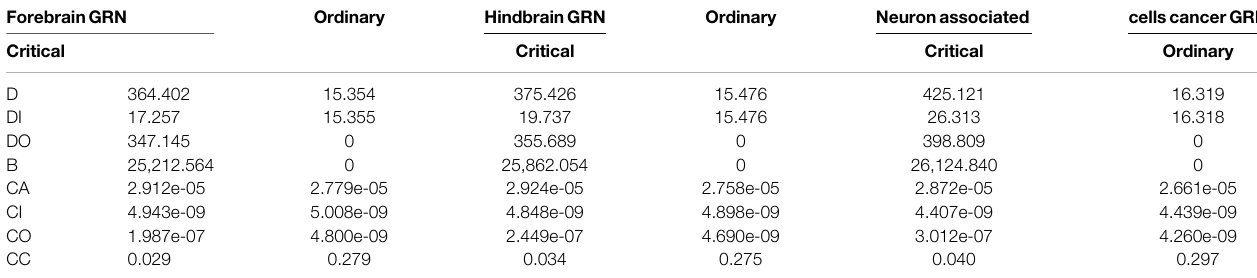
TABLE 2 | Topologicalanalysisofeachgenein humanbrainnetwork. ForebrainGRN Ordinary